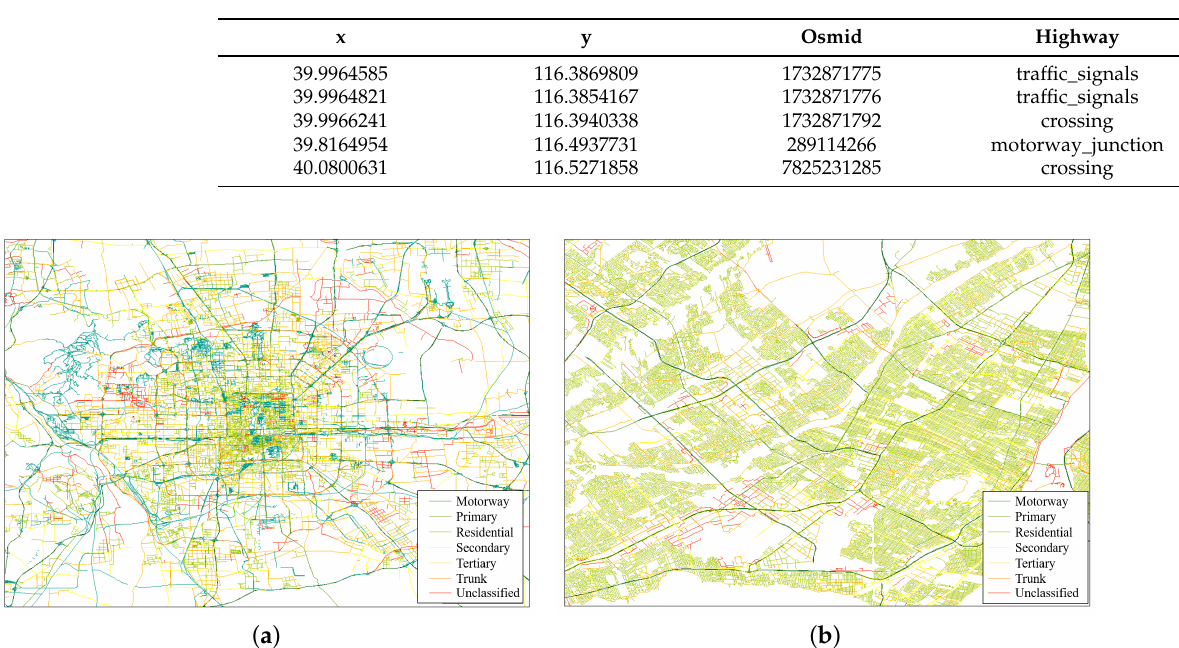
Table 4. Road network node.